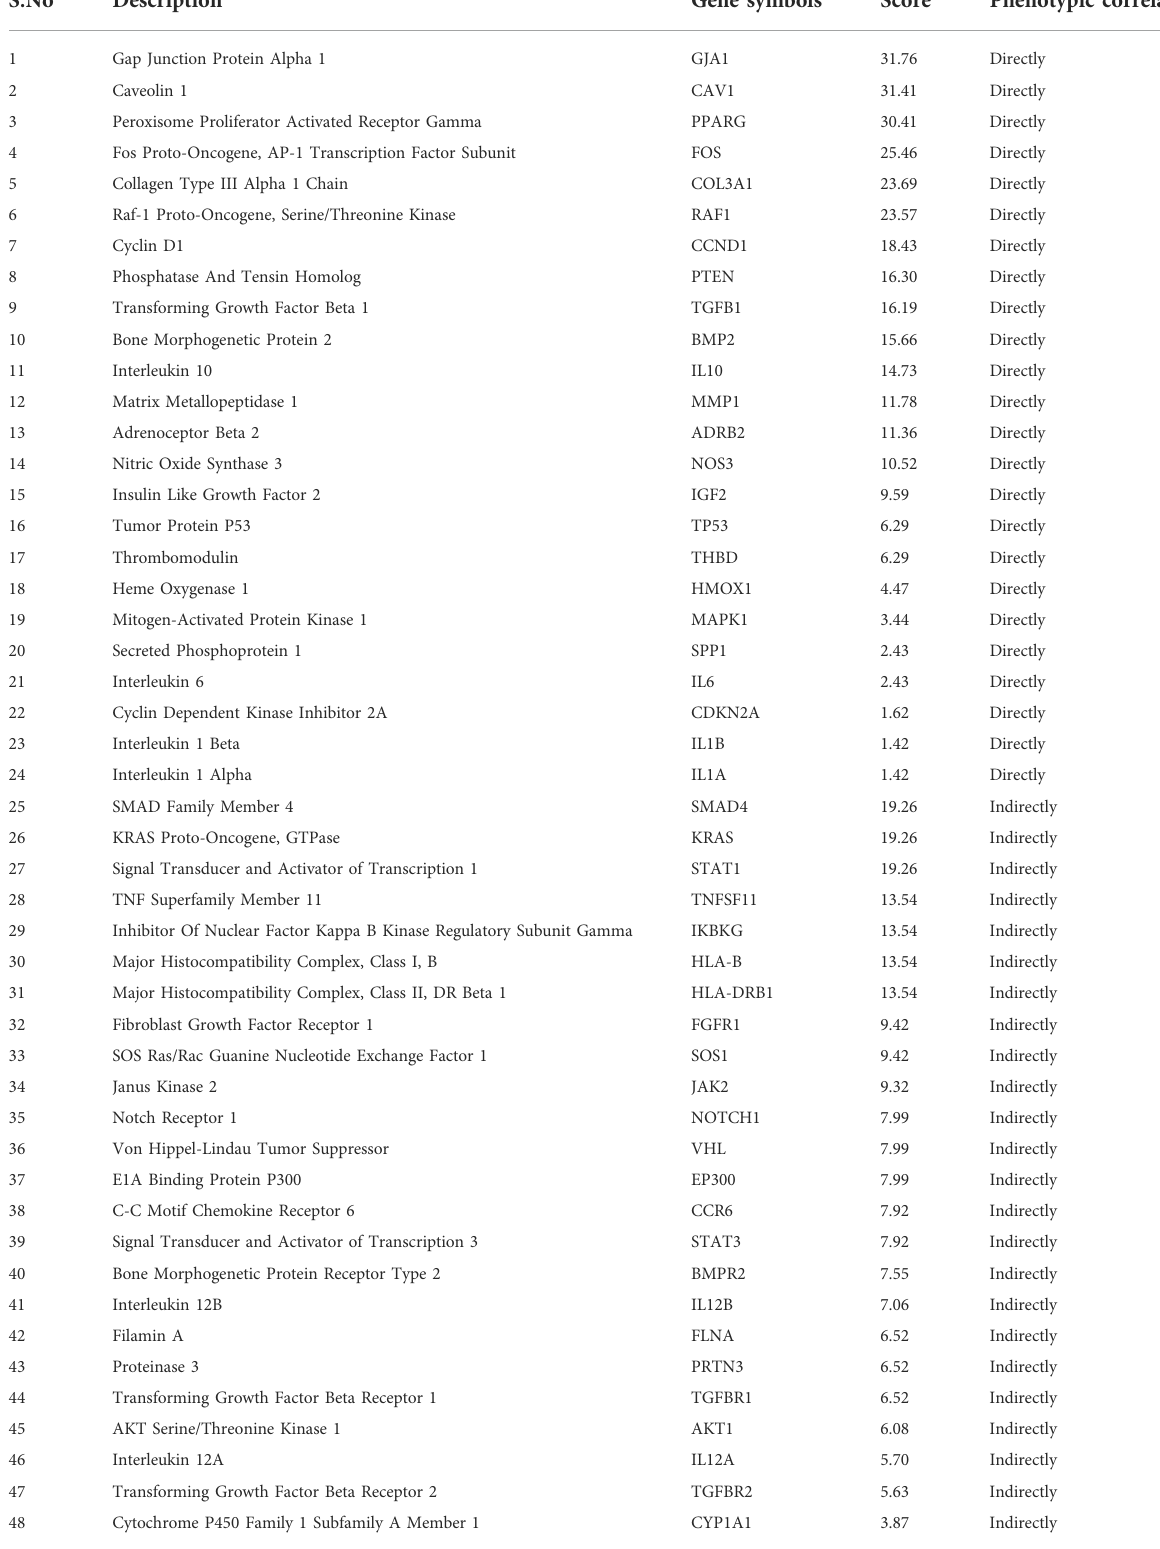
TABLE 2 Analysis of Quercetin targets with the phenotype “ Essential hypertension ” using